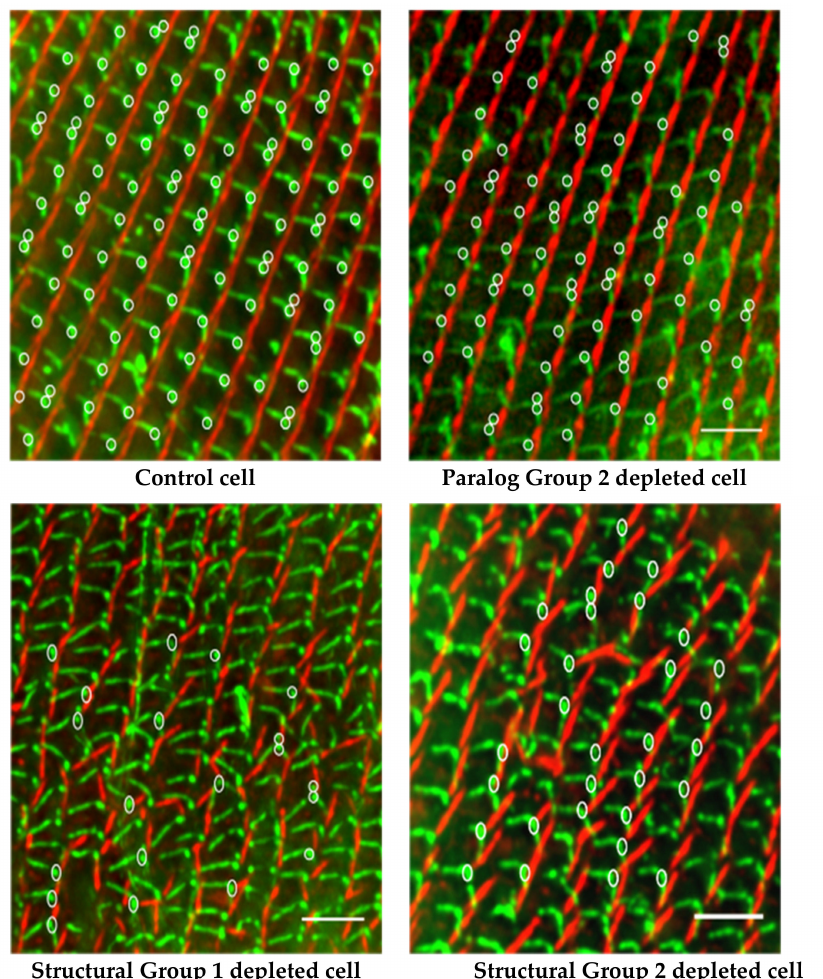
Figure 17. Striated rootlet structure and alignment disrupted by RNAi. Depletion of SR